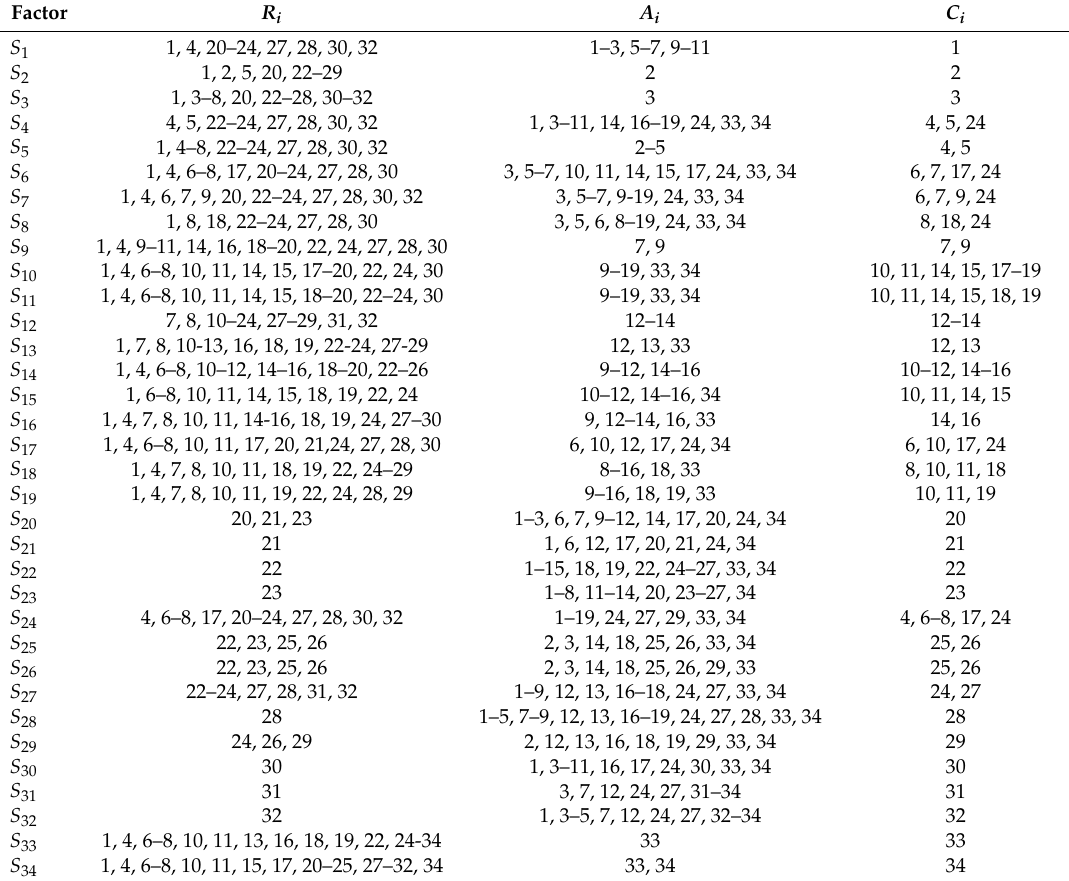
Table 5. Reachable set, antecedent set and collective set of each factor in the first round. Factor R i A i C